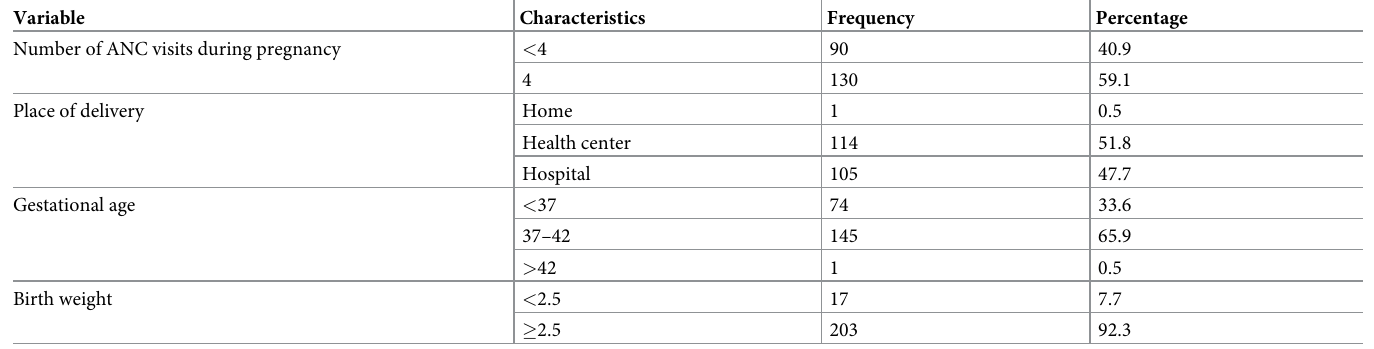
Table 2. Obstetric characteristics of mothers attending EPI unit of WKUSH,